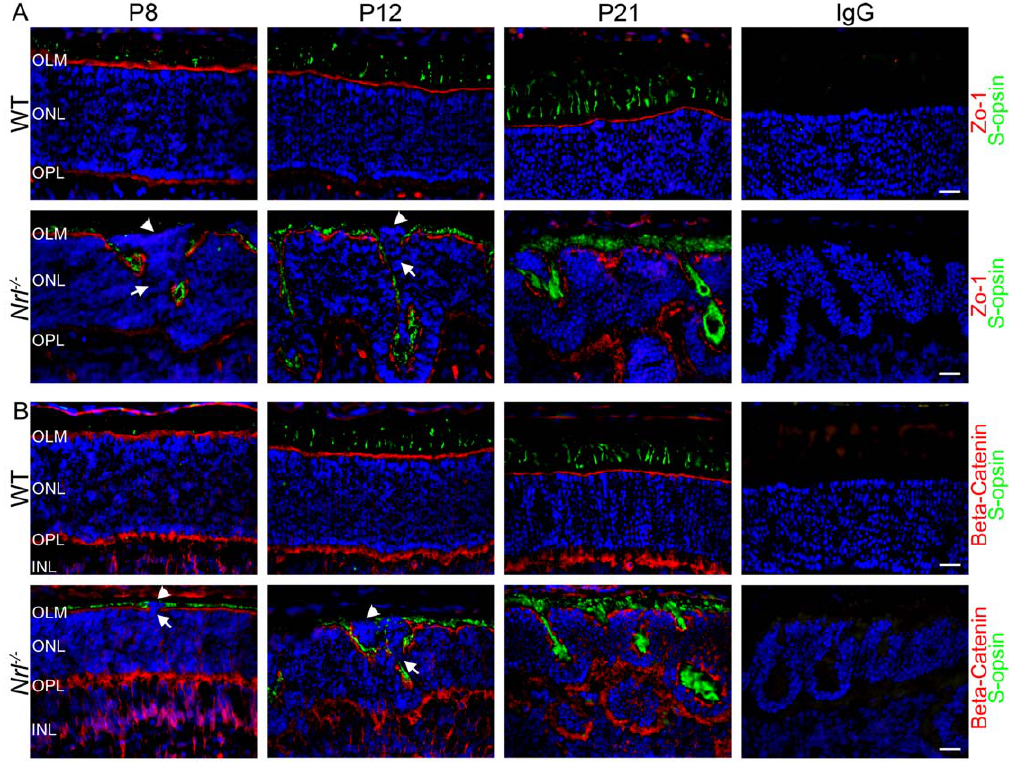
Figure 8. Defects in OLM formation are associated with rosette formation. To analyze the integrity of the OLM in the Nrl 2 / 2 retina, sections were stained with antibodies specific for Zo-1 and beta-catenin (red), components of the OLM junctions, and S-opsin (green) to label OSs. A. In the WT retina, the Zo-1 staining forms a straight continuous line. In the Nrl 2 / 2 retina, gaps in OLM staining (arrows) can be seen that correspond spatially and temporally with the appearance of nascent rosettes and aberrant photoreceptors (arrowheads). B. Beta-catenin staining can be seen at the OLM as well as in the OPL and INL. In the Nrl 2 / 2 retina, gaps in OLM staining (arrows) can be seen that correspond with the appearance of nascent rosettes and aberrant photoreceptors (arrowheads). OLM: outer limiting membrane, ONL: outer nuclear layer, INL: inner nuclear layer. Scale bar, 20 m m.